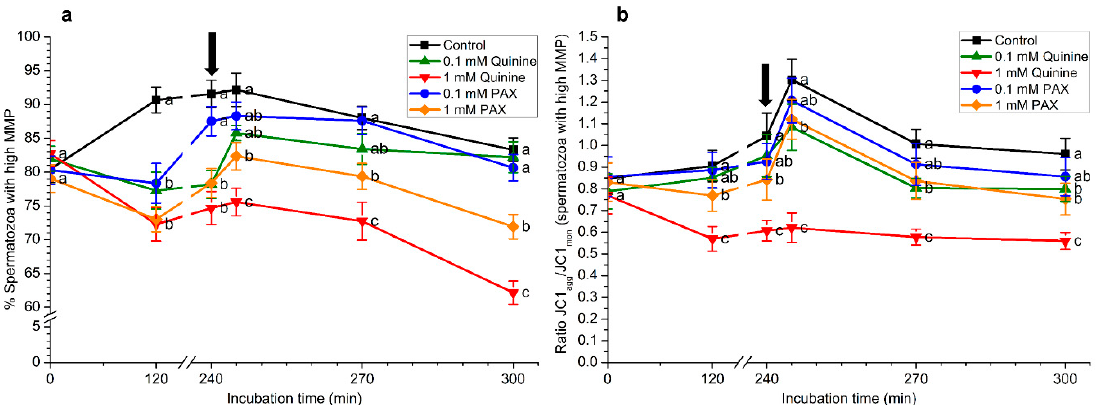
Figure 4. ( a ) Percentages of spermatozoa with high mitochondrial membrane potential (MMP) and ( b ) their JC1 agg /JC1 mon ratios during in vitro capacitation and progesterone-induced acrosomal exocytosis (300 min) in the presence of 0.1 mM quinine, 1 mM quinine, 0.1 mM paxilline (PAX), and 1 mM paxilline. Black arrow indicates the time at which 10 µ g/mL progesterone was added to induce acrosomal exocytosis (i.e., 240 min). Different letters (a–c) mean significant ( p < 0.05) differences between treatments at a given time point. Data are shown as mean ± SEM for 15 independent experiments.